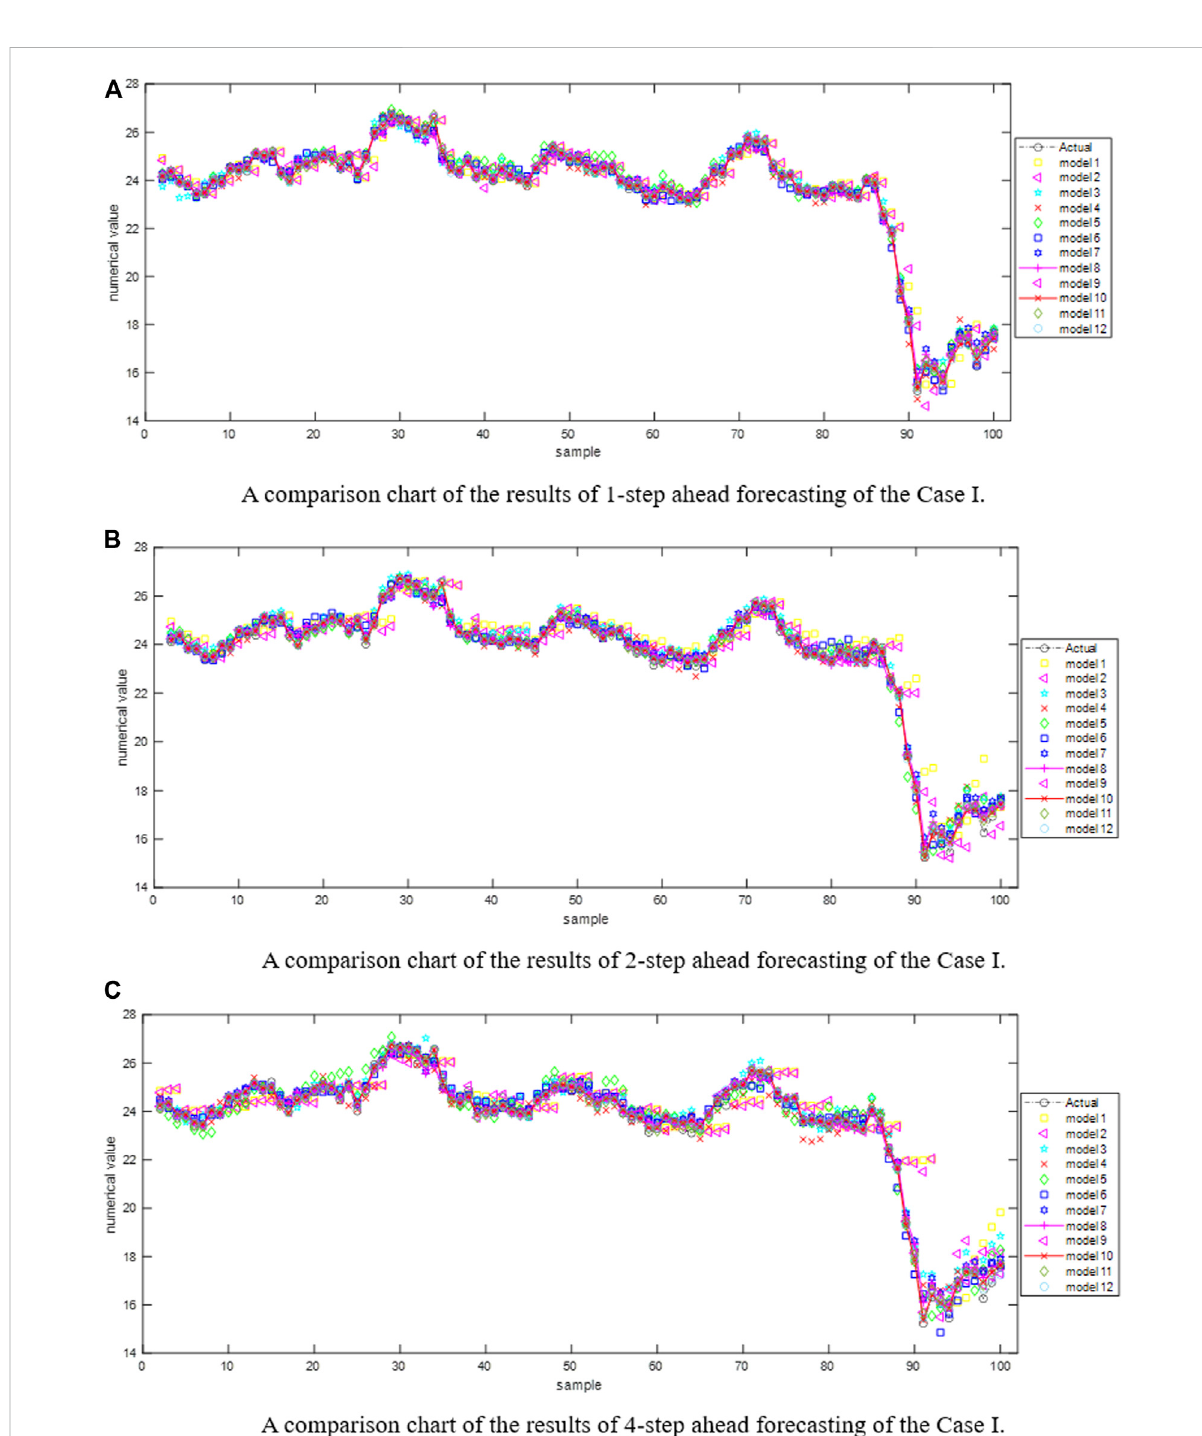
FIGURE 3 A comparison chart of the results of multi-step ahead forecasting of the Case